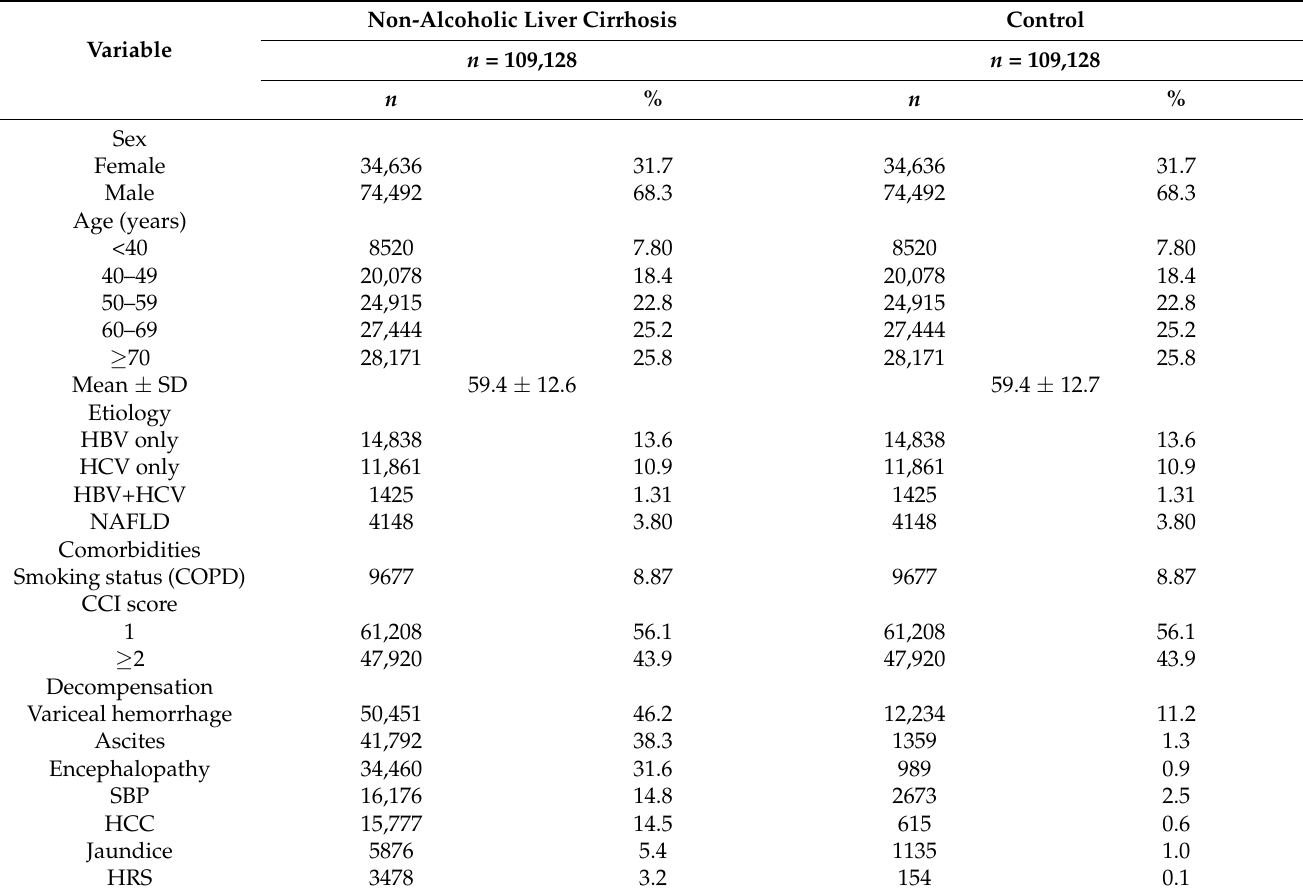
Table 1. Baseline characteristics of the study and control